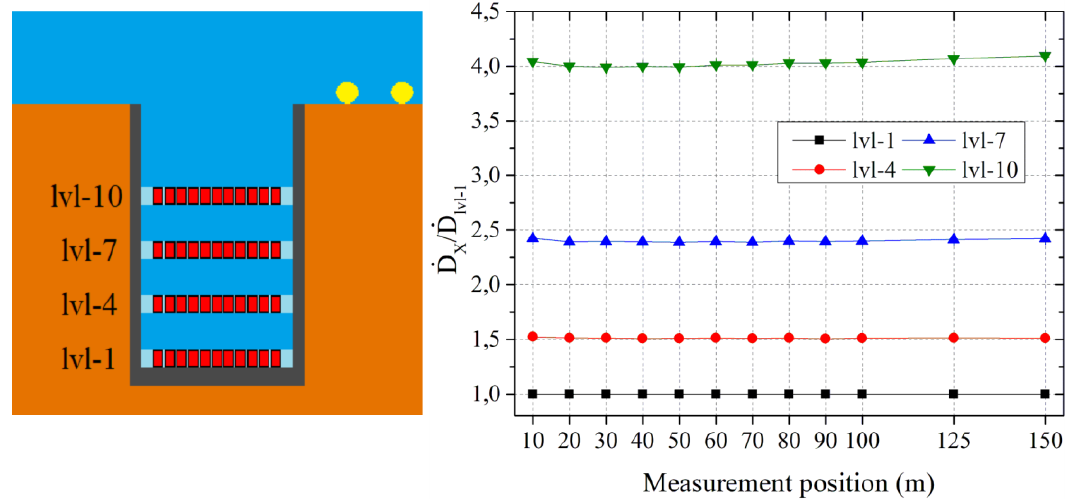
Figure. 4. The simplified one-layer model for 4 different repository configurations: lvl-1, lvl-4, lvl-7and lvl-10 (left) and their relative influence of the γ - dose rate values in dependence on 12 measurement positions